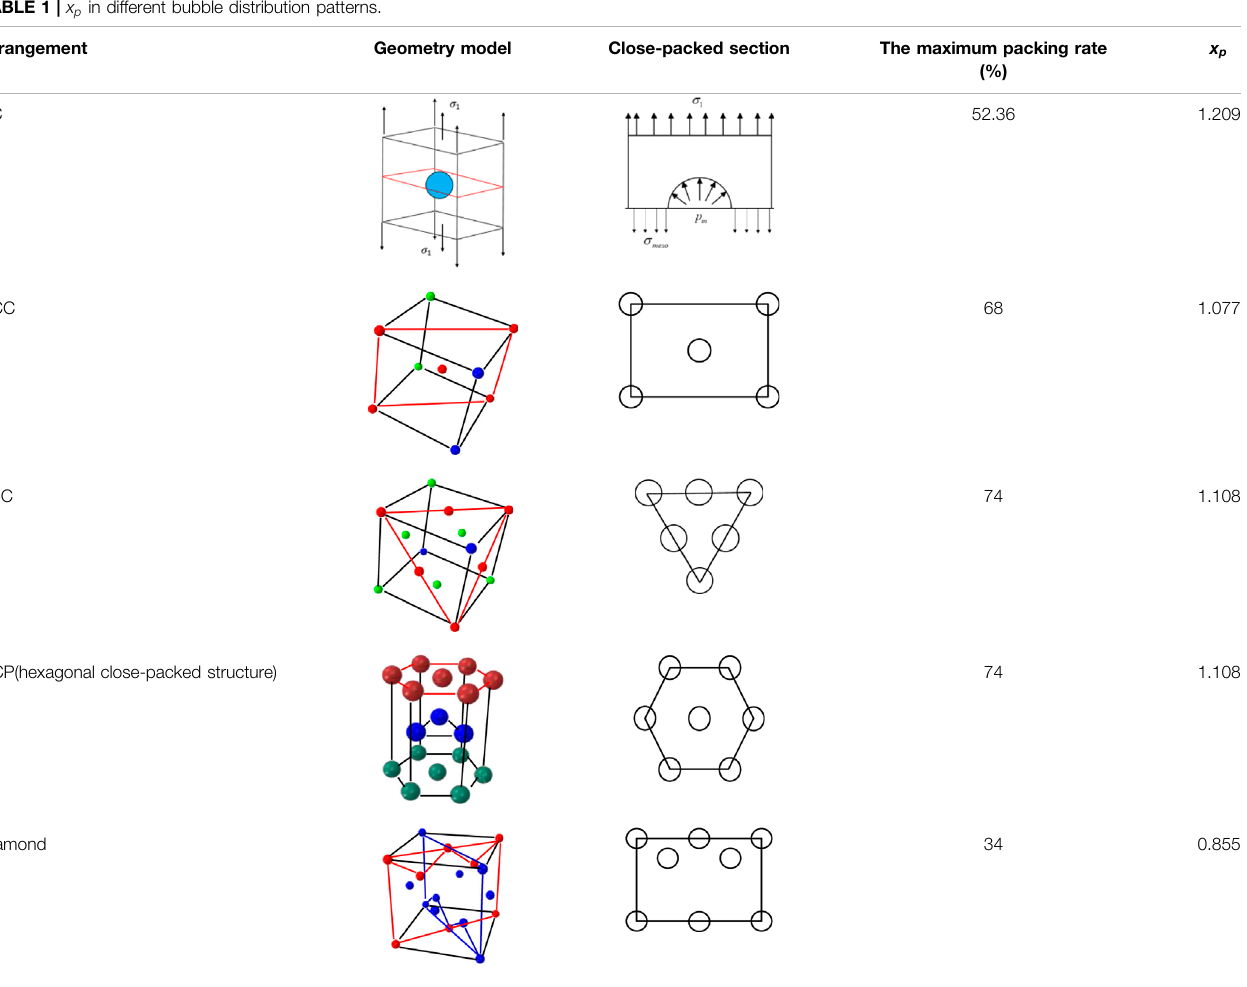
TABLE 1 | x p in different bubble distribution